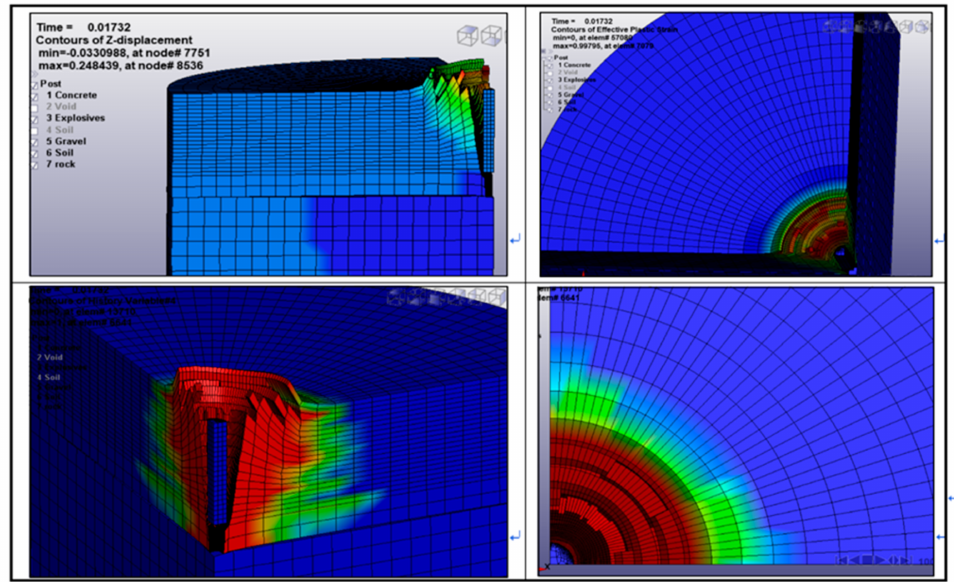
Figure 5. Result of strain and pressure.